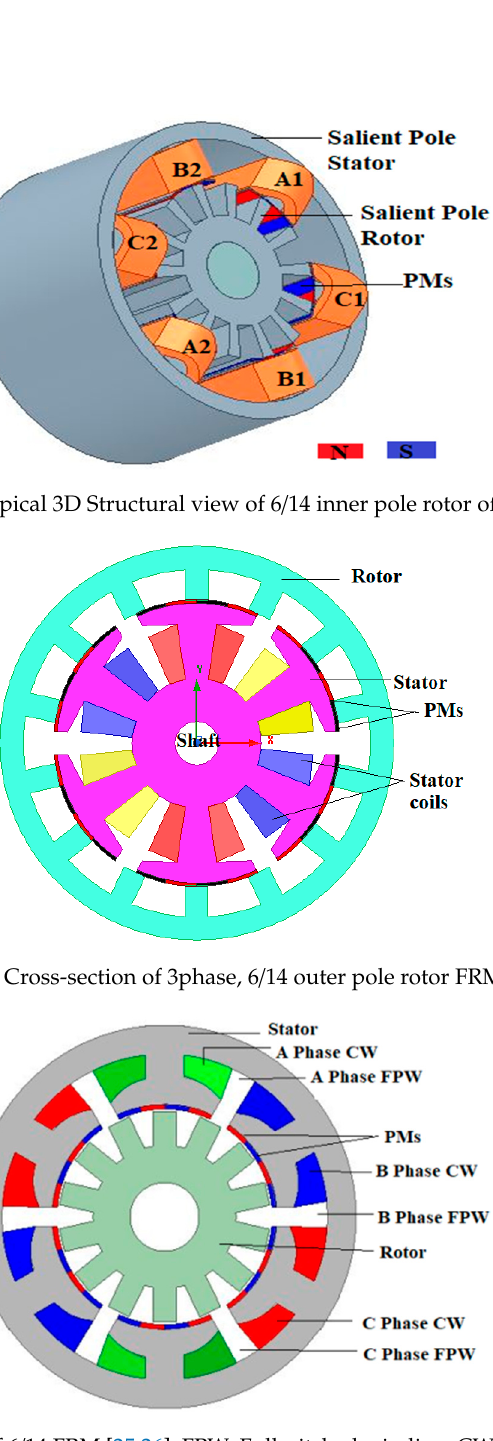
Figure 9. Structural-view of 6/14 FRM [25,26]; FPW: Full-pitched winding, CW: Concentrated winding.